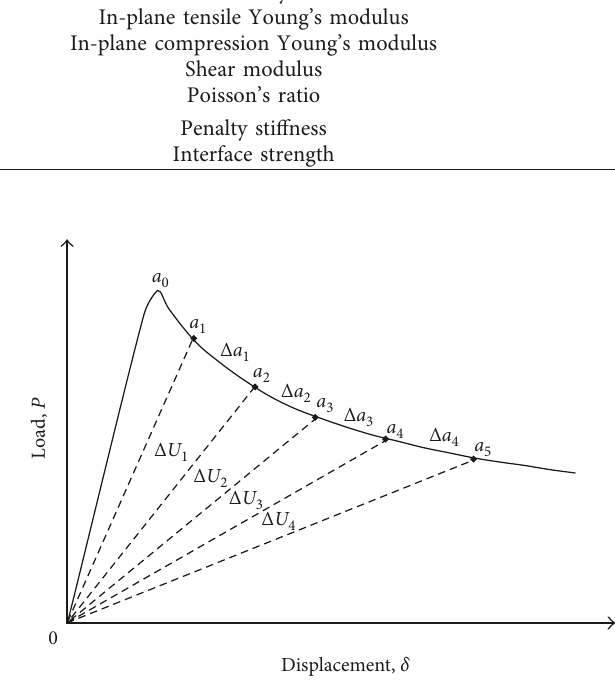
Figure 3: Area method of fracture energy determination.